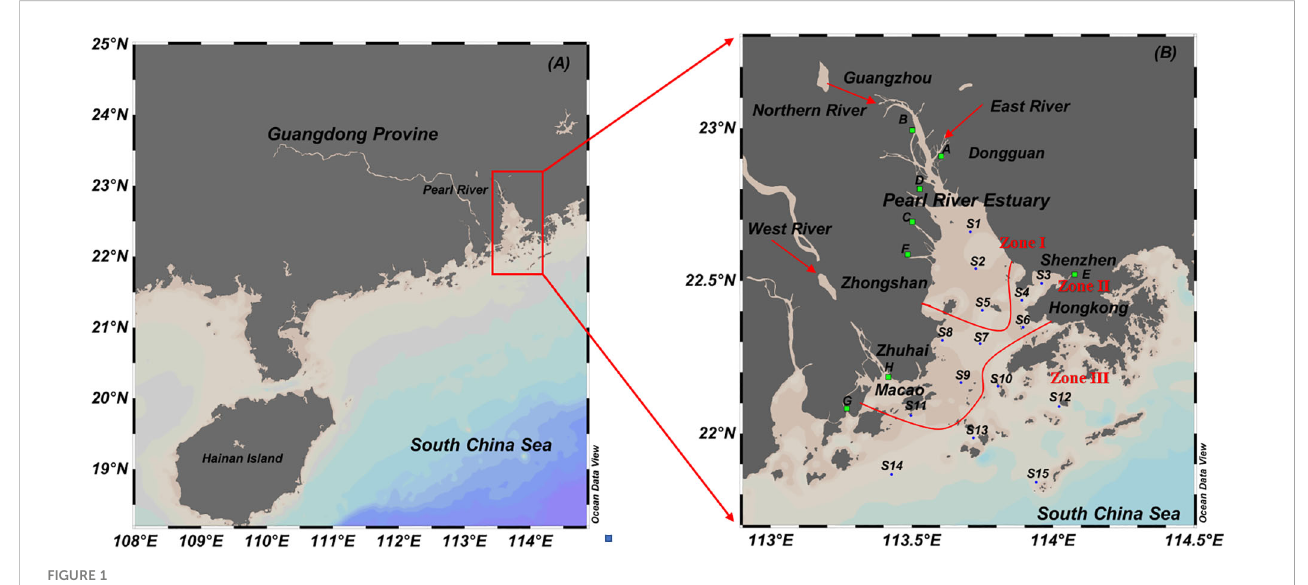
FIGURE 1 Geographical location of the PRE (A) and monitoring stations (B)